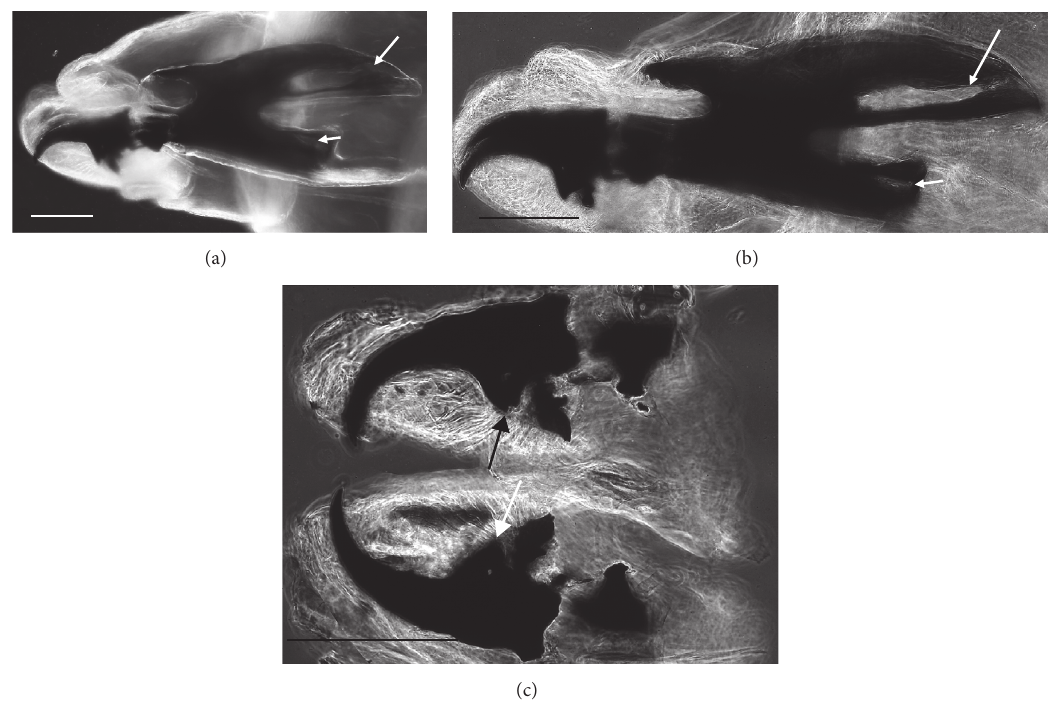
Figure 3: Sarcophaga third instar larva: LM image: (a) cephaloskeleton with dorsal cornua showing window apparently 8-shaped (arrow) while the ventral cornua window is smaller but still well developed (arrowhead). (b) Same sample showing a different shape (more elongated and not 8-shaped) of the window due to a different orientation of the sample in the slide. (c) Detail of the ventral bridge of the intermediate sclerite with truncated tip (arrows). Scale bar: 100 𝜇